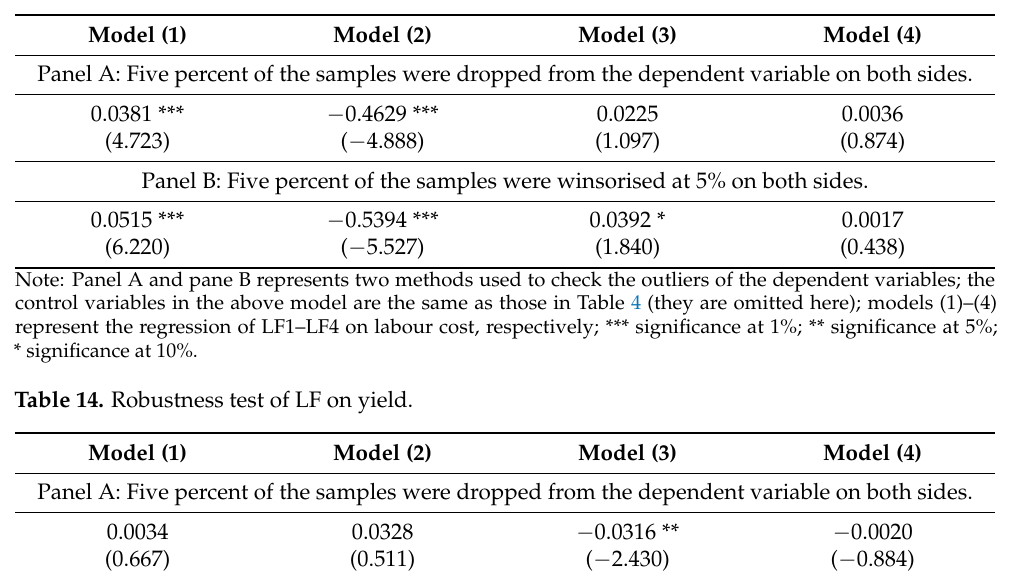
Panel A: Five percent of the samples were dropped from the dependent variable on both sides. 0.0034 0.0328 Panel B: Five percent of the samples were winsorised on both